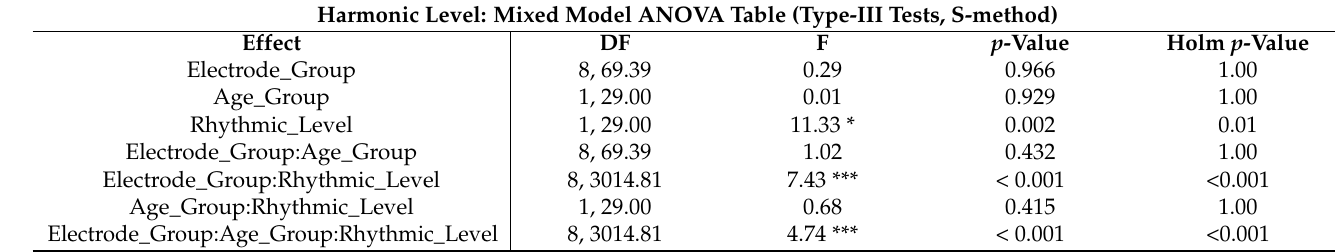
Table 5. Harmonic Level—ANOVA Table. For the harmonic level, a linear-mixed effect model returned a significant three-way interaction between electrode group*rhythmic level*age group fixed effects on phase-locking values (PLV) to